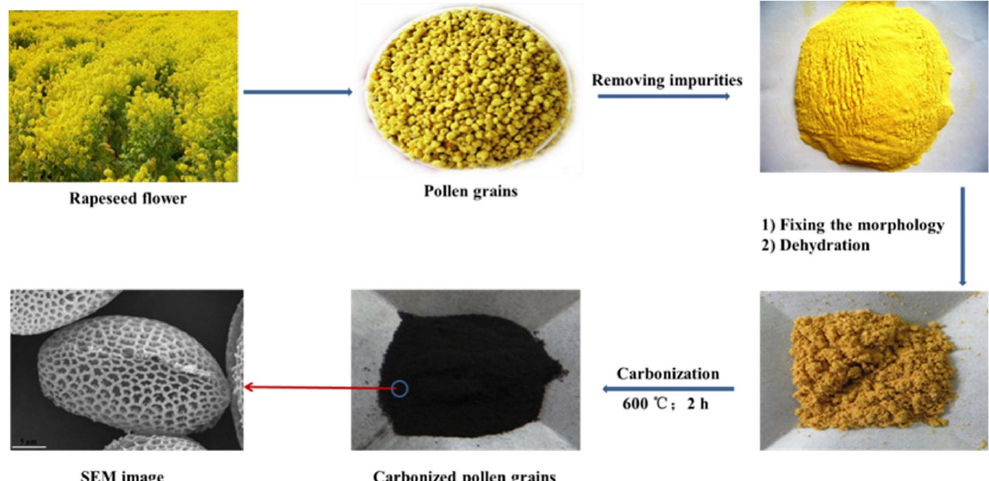
Figure 13. Photos and SEM image showing the carbon aerogel composite made from rapeseed flower pollen grains. The SEM image reveals the biological structure derived from that of the original pollen grains. Reproduced with permission from [32], ©2017 Elsevier B.V.